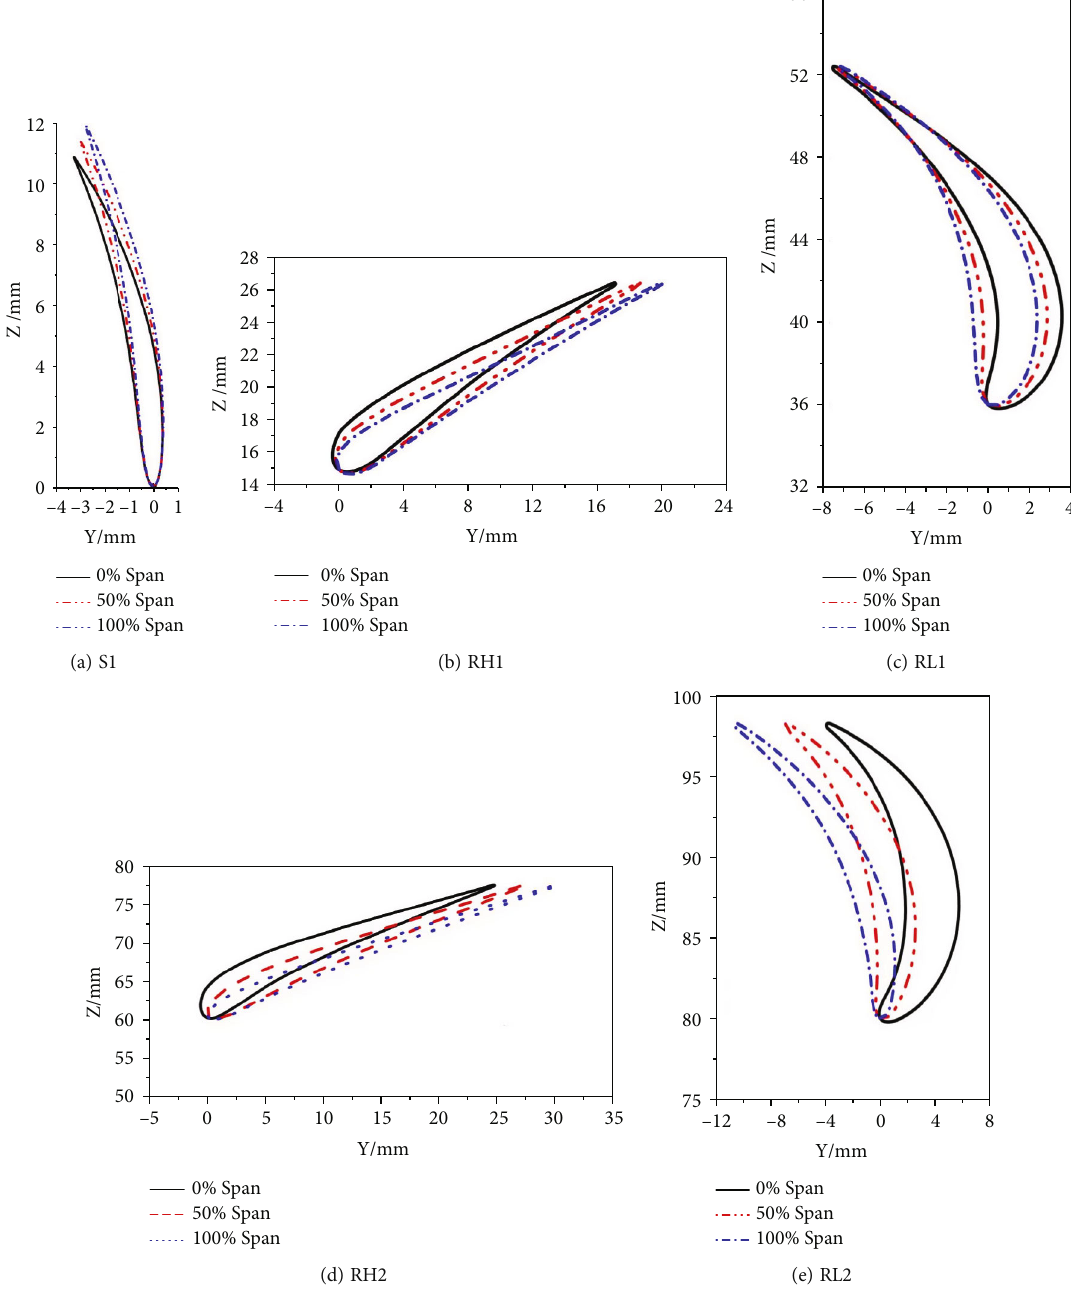
Figure 6: Blade pro fi les at tip, midspan, and root for S1, RH1, RL1, RH2, and